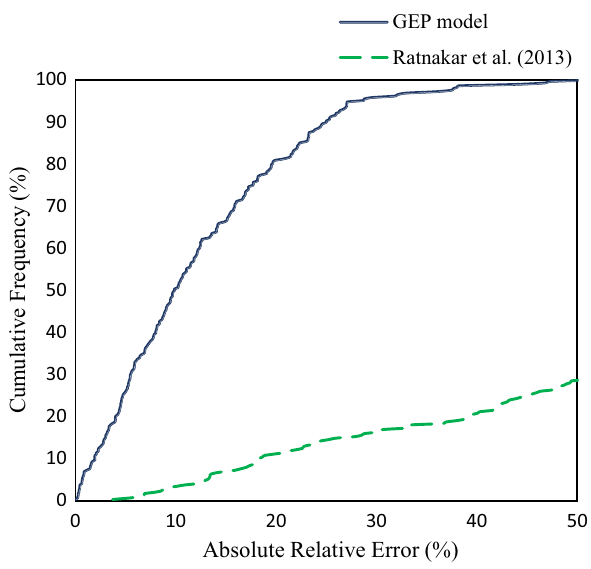
Fig. 11 A comparison between the cumulative frequency of errors associated with the GEP model and the Ratnakar et al. [36] correla-